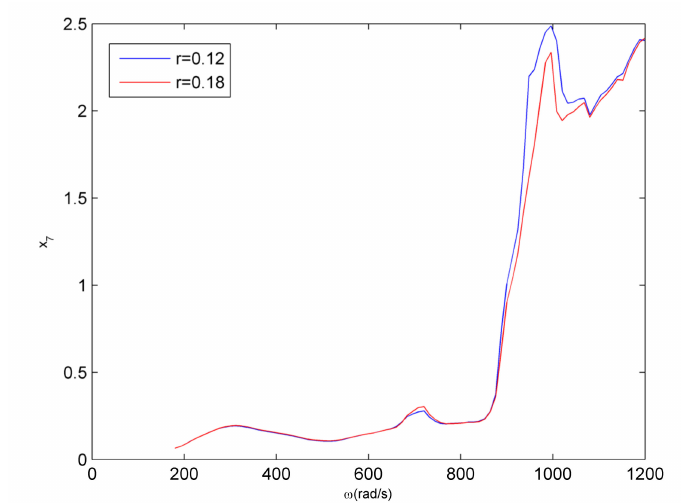
Figure 16. Bifurcation diagrams for coupled fault system. ( a ) r = 0.12. ( b ) r = 0.18.